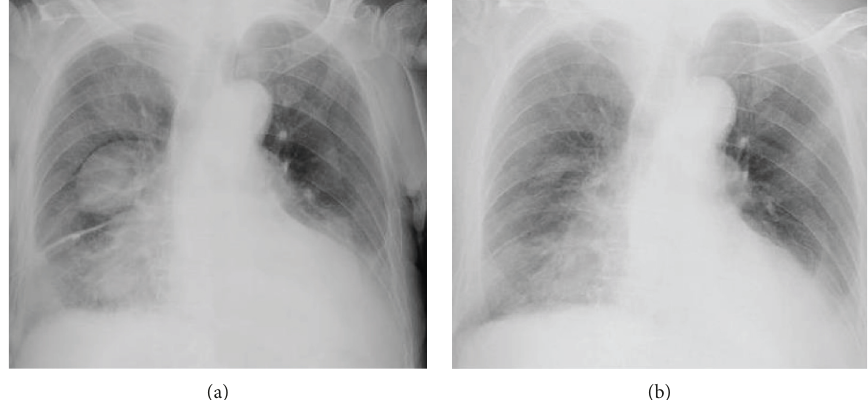
Figure 7: Chest radiograph. (a) Chest drainage removal date (June 28, 2021). (b) End date of 3 courses of triple therapy (September 9,